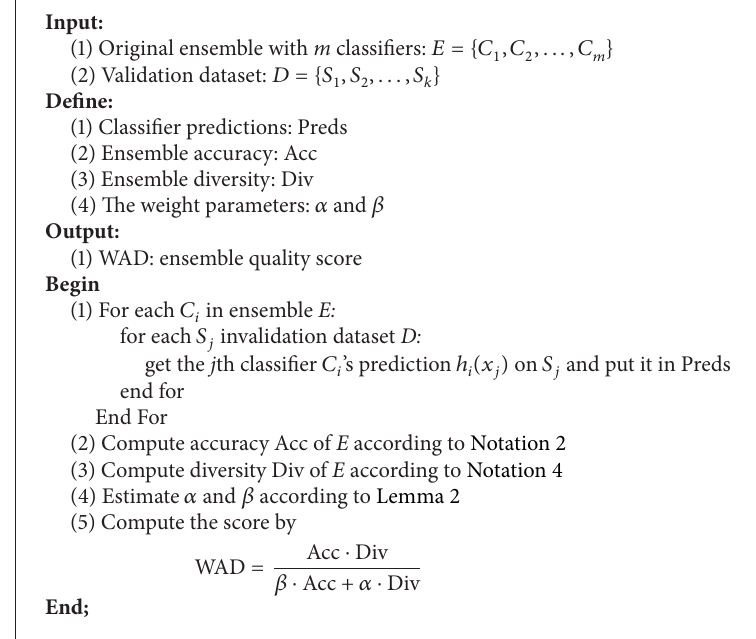
Pseudocode 1: The pseudocode to compute the WAD